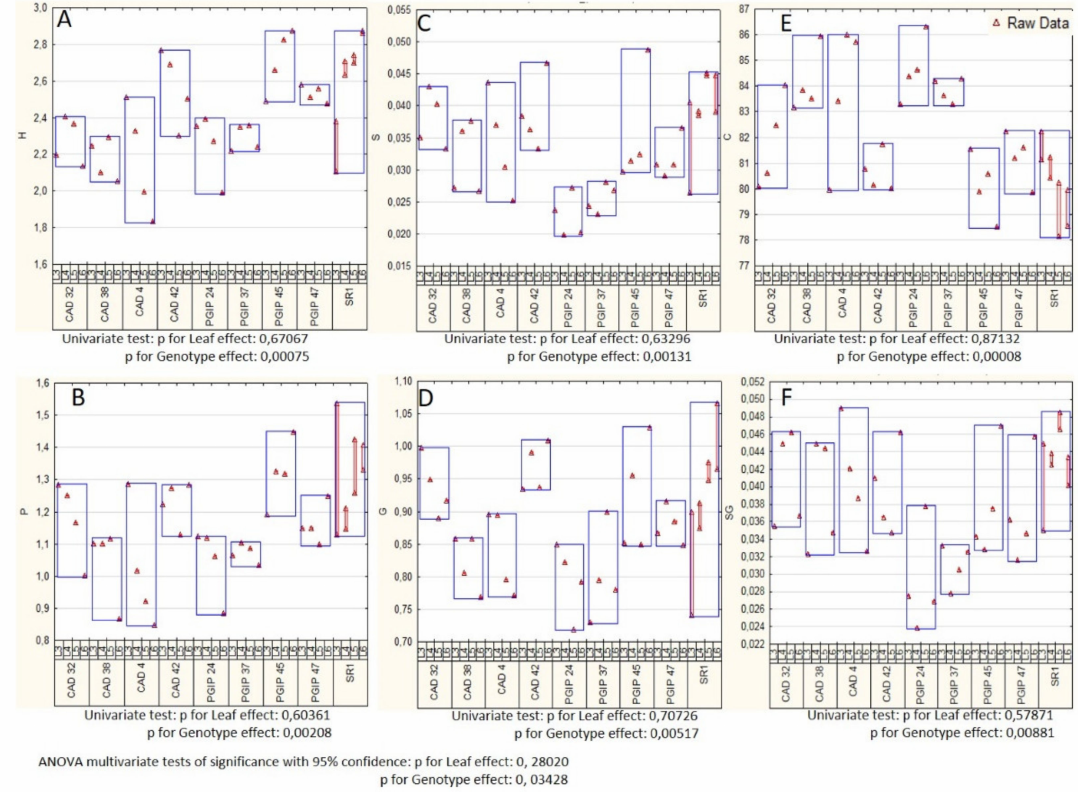
Figure 2. ANOVA box plots (multivariate tests of significance with 95% confidence intervals) of Py-GC–MS data for each analyte category SR1 vs transgenic plant lines. ( A ): p-hydroxyphenol (H); ( B ): generic phenolics (P); ( C ): syringyl (S); ( D ): guaiacyl (G); ( E ): carbohydrate related components; and ( F ): syringyl / guaiacyl ratio (SG). Data from SR1 constitute eight biological repeats whereas all other lines represent four biological repeats per transgenic